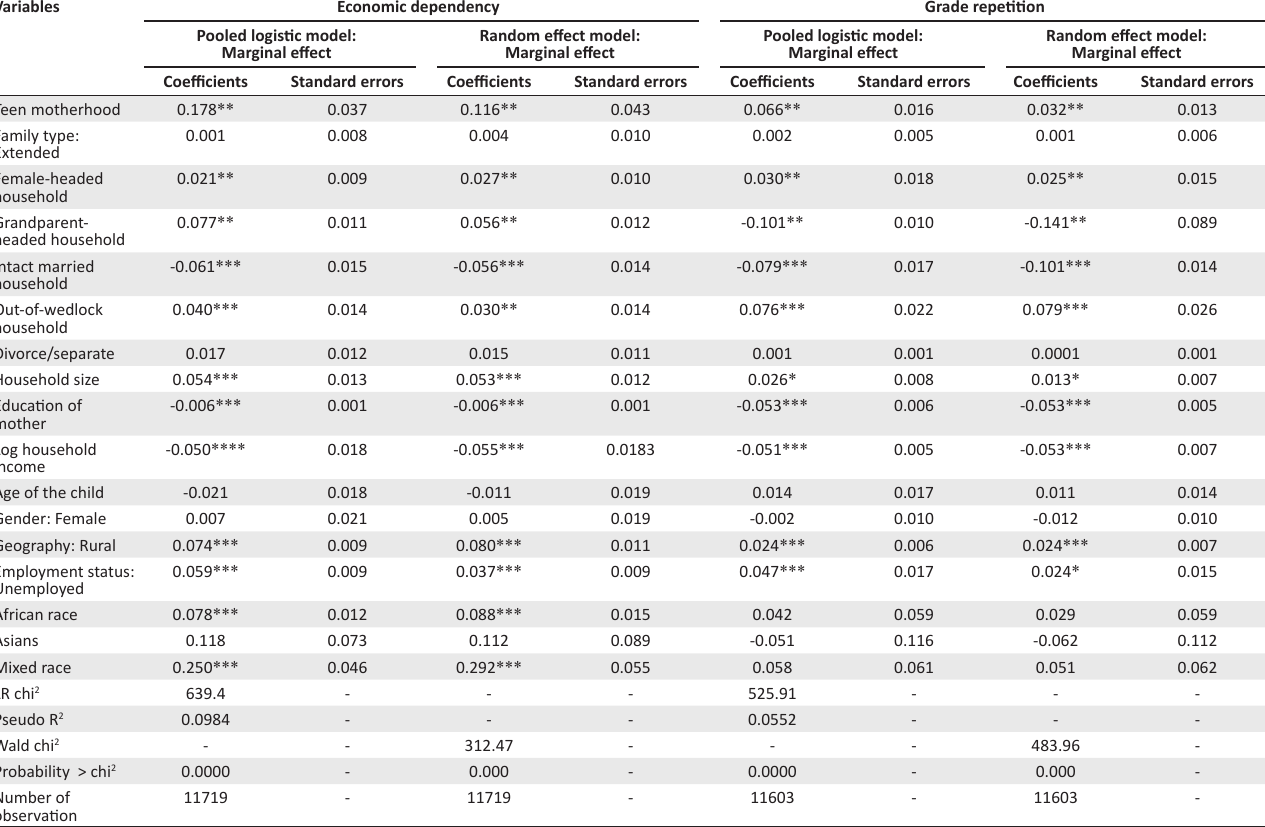
TABLE 2: Results of pooled logistic and random effect models: Effects of early motherhood on economic dependency and grade repetition.